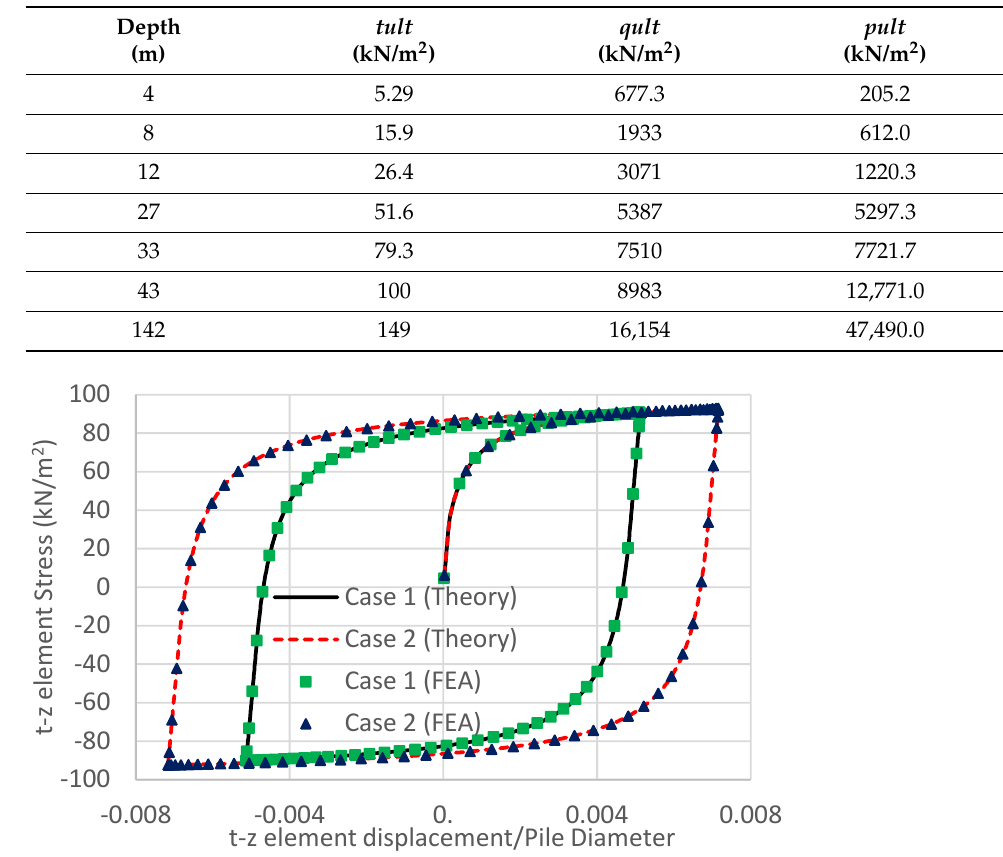
Figure 2. Comparisons of the displacement–stress curves between the theoretical and finite element methods.